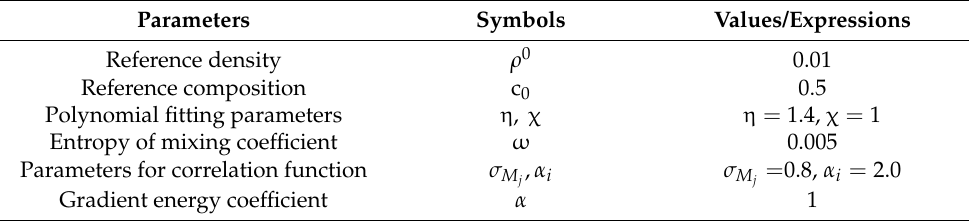
Table 1. Parameters of PFC